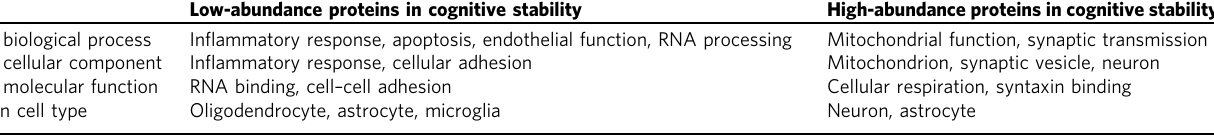
The table summarizes gene ontology (GO) and cell-type enrichment analysis for the 579 cognitive trajectory-associated proteins categorized as either low- or high-abundance in cognitive stability. The underlying data are provided as a Supplementary Data